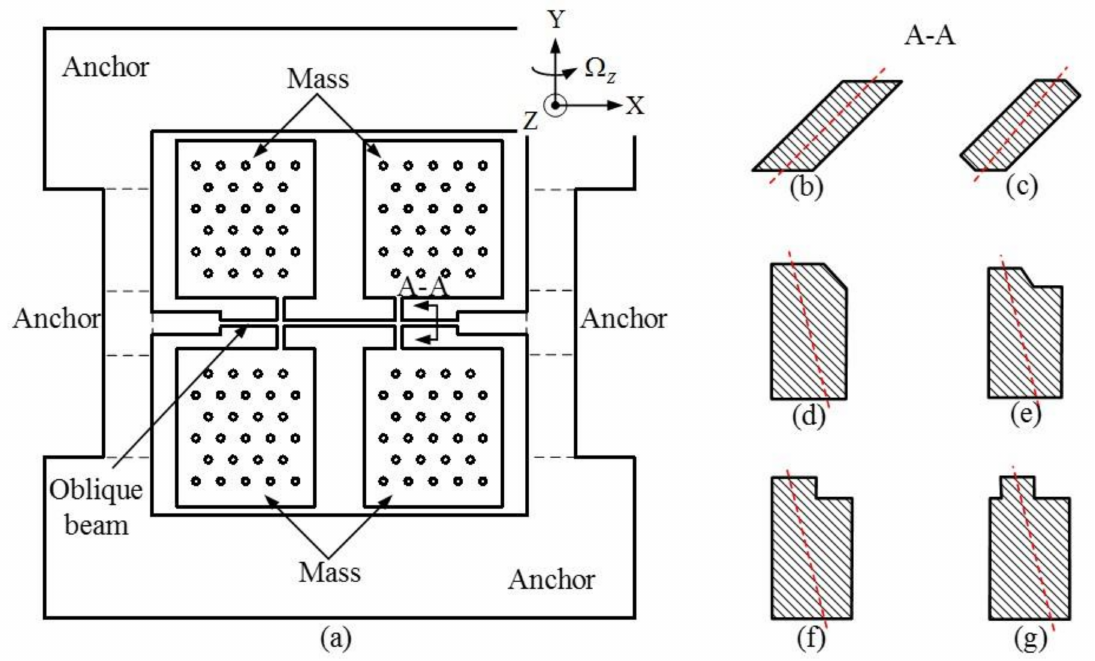
Figure 2. Vibratory structure of the BFVG. ( a ) The prototype of the gyroscope; ( b ) An oblique beam with a parallelogram cross-section; ( c ) An oblique beam with a hexagonal cross-section; ( d ) An oblique beam with a pentagon cross-section; ( e ) An oblique beam with a platform of pentagon cross-section; ( f ) An oblique beam with an L-shaped cross-section; ( g ) An oblique beam with a convex